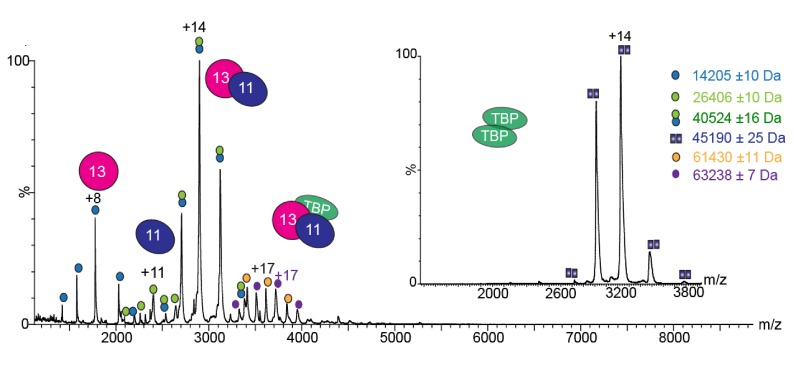
Native mass spectrometry (MS) analysis of TAF11/TAF13/TBP complex.Mass spectrum of the TAF11/TAF13/TBP complex recorded from a buffer solution containing 150 mM ammonium acetate (pH7.5). Two charge state series are observed corresponding to complex with (circles filled in purple) and without (circles filled in orange) an oligo-histidine affinity purification tag, respectively. Calculated masses: 20659 Da (TBP); 22765 Da (TBP with His-tag); 45531 Da (TBP dimer); 40691 Da (TAF11/TAF13). The inset shows the native MS spectrum recorded for separately purified TBP alone, evidencing a TBP dimer.